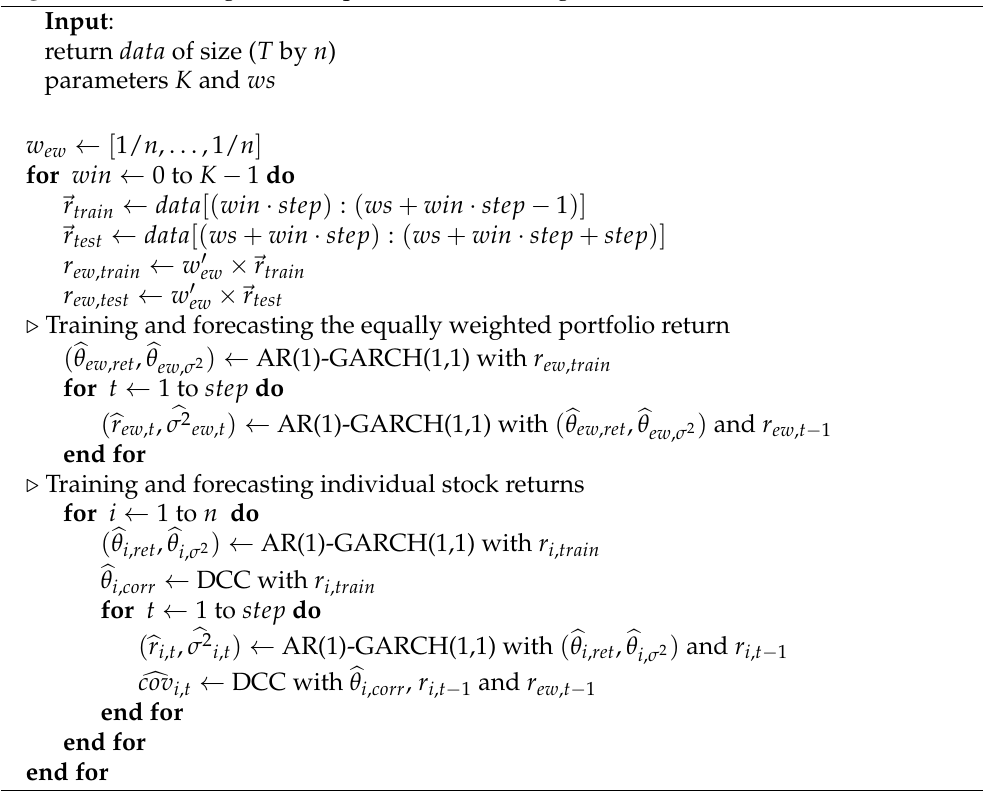
Algorithm 1 Training and 1 Step Ahead Forecasting of Return and